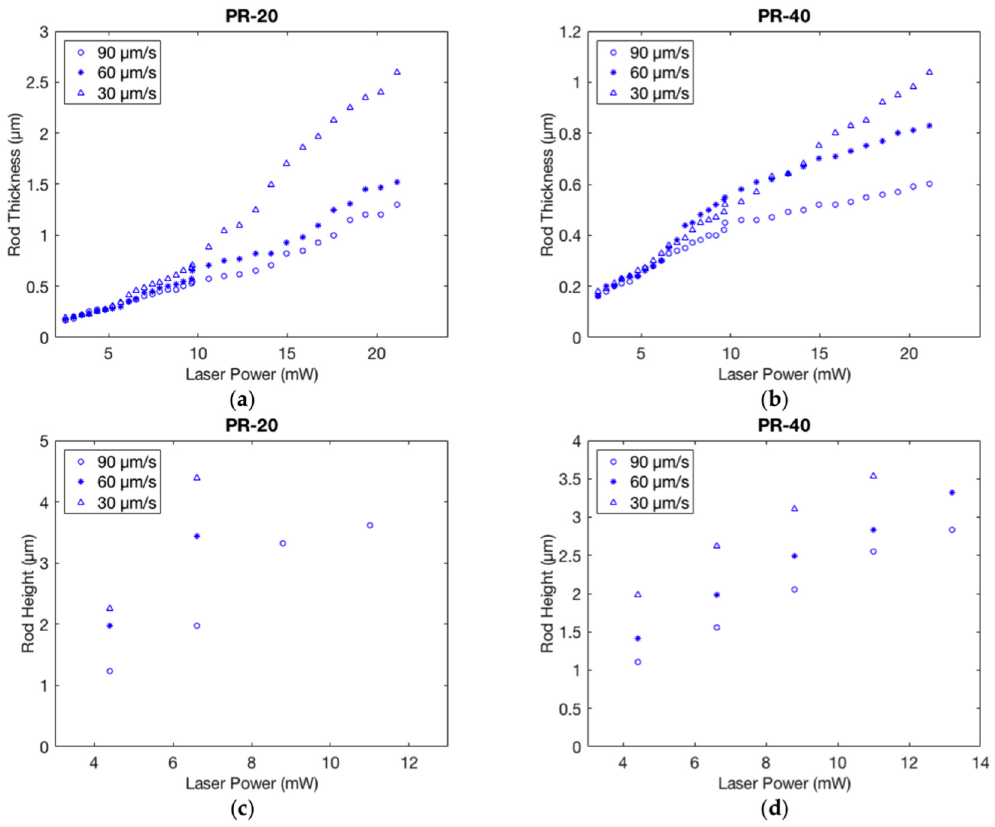
Figure 5. Thicknesses and heights of the voxel depending on the writing speed and the laser power.